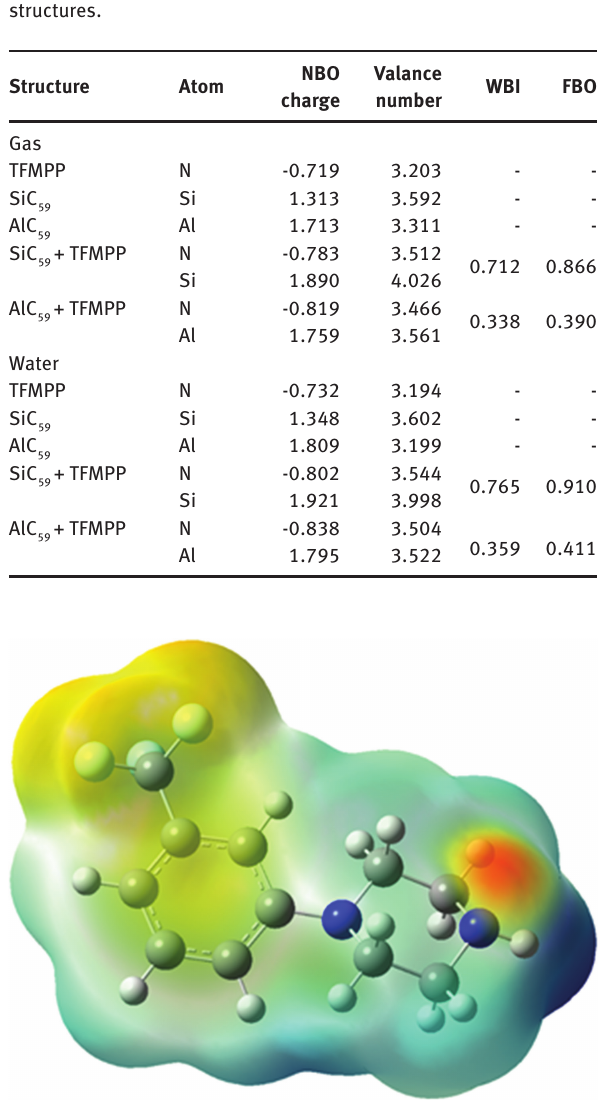
Figure 1: Electrostatic potential map of TFMPP.